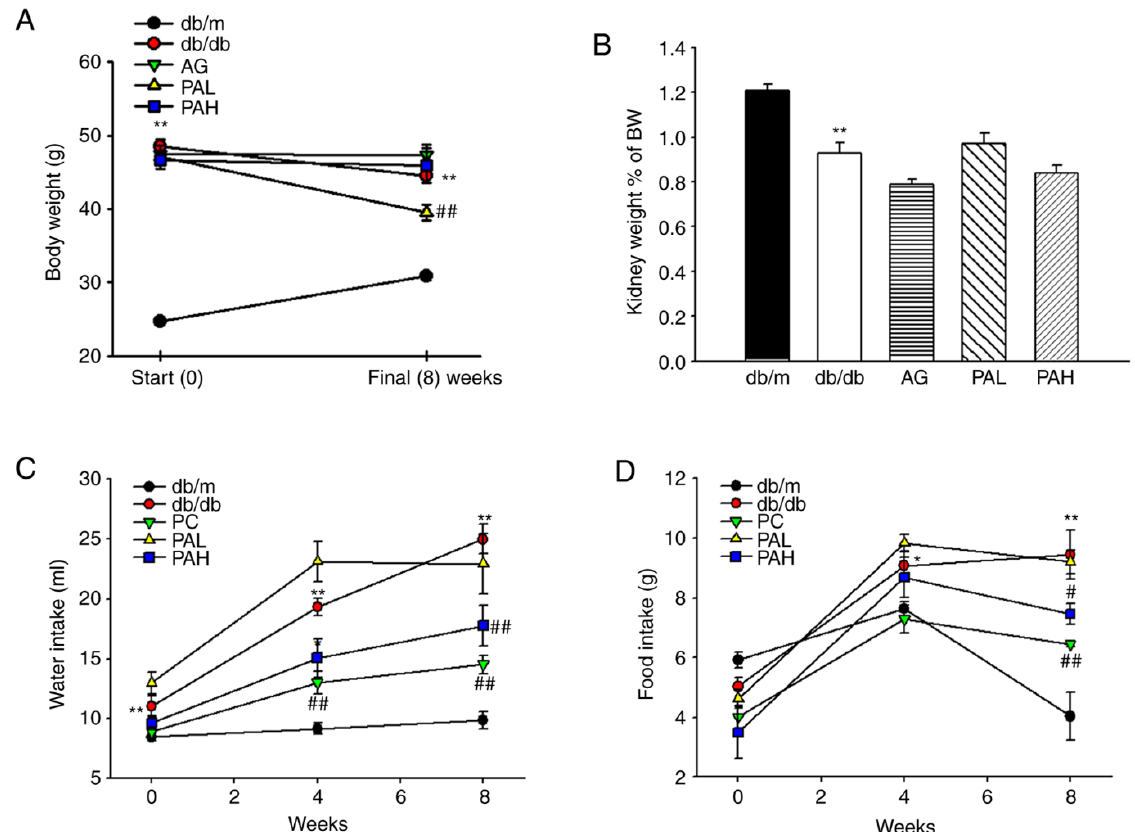
Figure 2. Effects of ER-PA on ( A ) body weight; ( B ) kidney weight; ( C ) food intake and ( D ) water intake in db/db mice. Data are presented as mean ± standard deviation ( n = 8). * p < 0.05, ** p < 0.01 vs. db/m; # p < 0.05, ## p < 0.01 vs. db/db. PA, Polygoni avicularis ; BW, body weight.